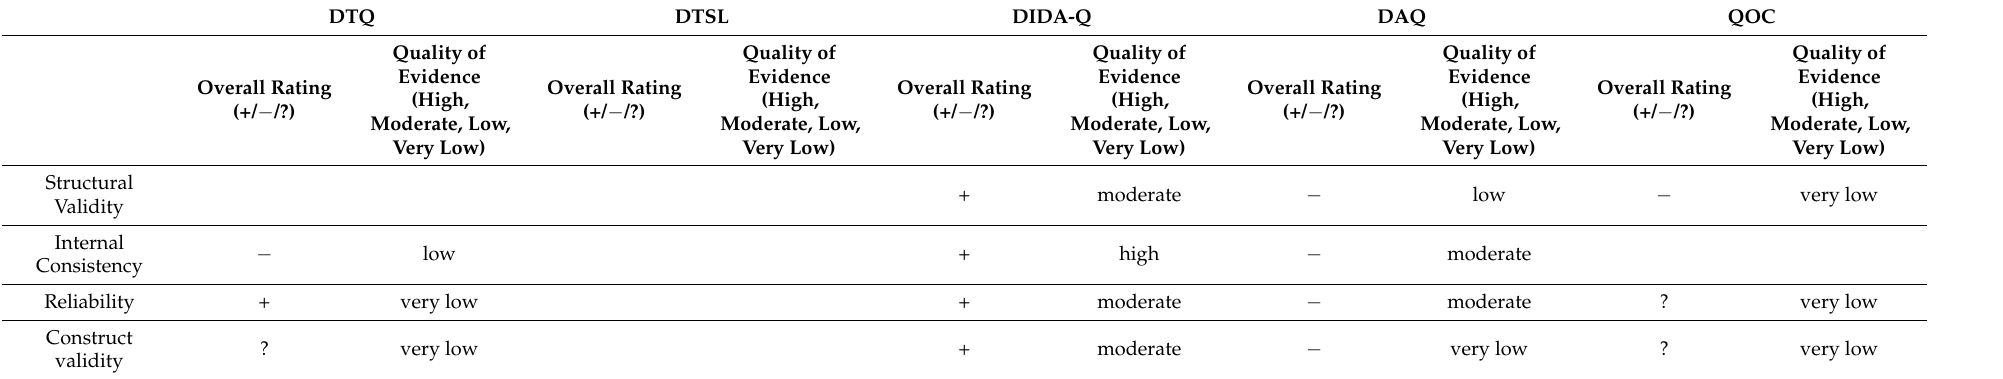
Table 4. Quality of the evidence for psychometric properties of the PROMs.